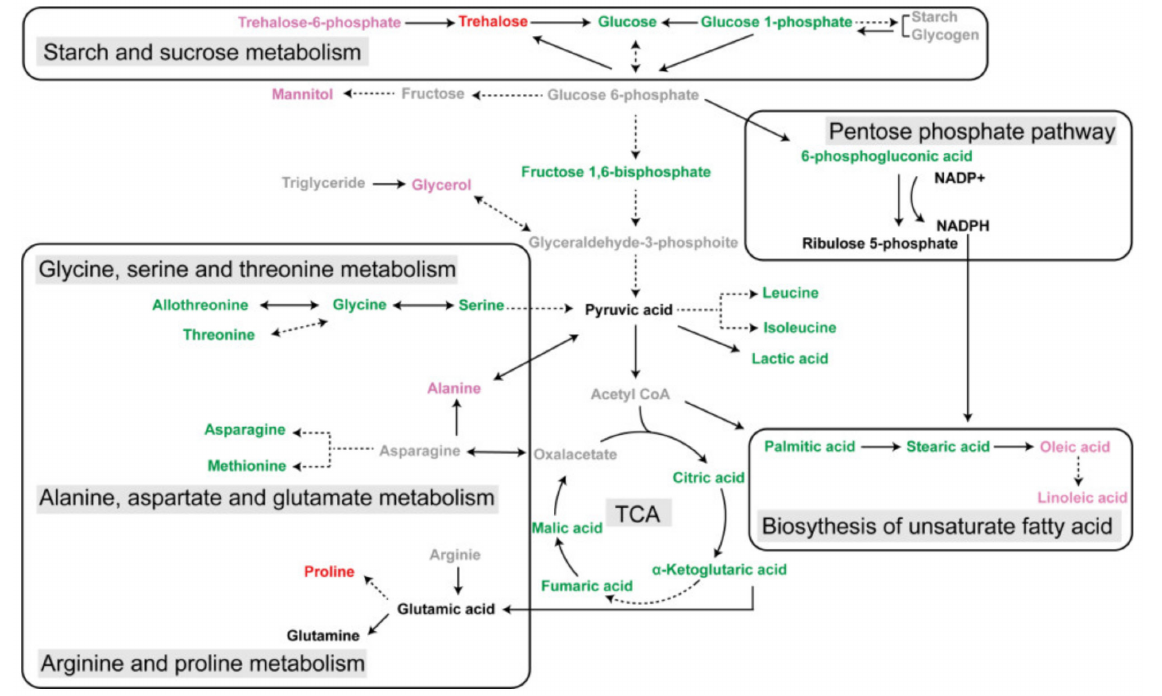
Figure 7. Relationships among the principal metabolic pathways of key differential metabolites during the diapause program of Sitosiplosis mosellana . Grey, no detection; green, lower at both diapause (D) and post-diapause quiescence stages (PDQ); pink and red, higher at both D and PDQ; red, the highest at